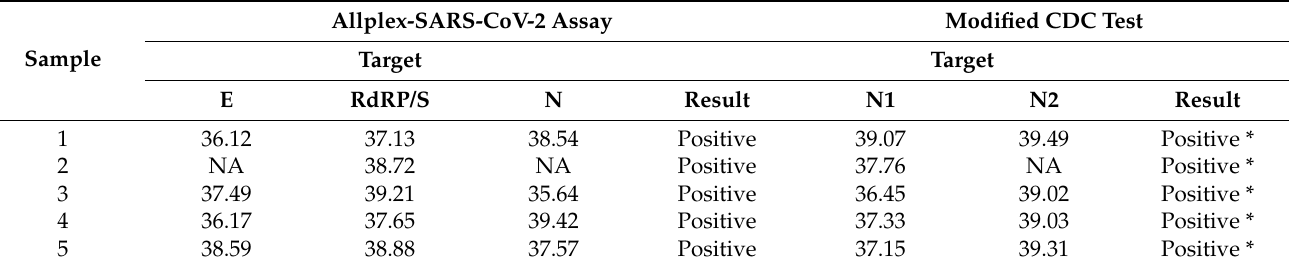
Table 5. Comparison of Ct values between the commercial (Allplex-SARS-CoV-2) and the modified CDC test for samples below the test’s limit of